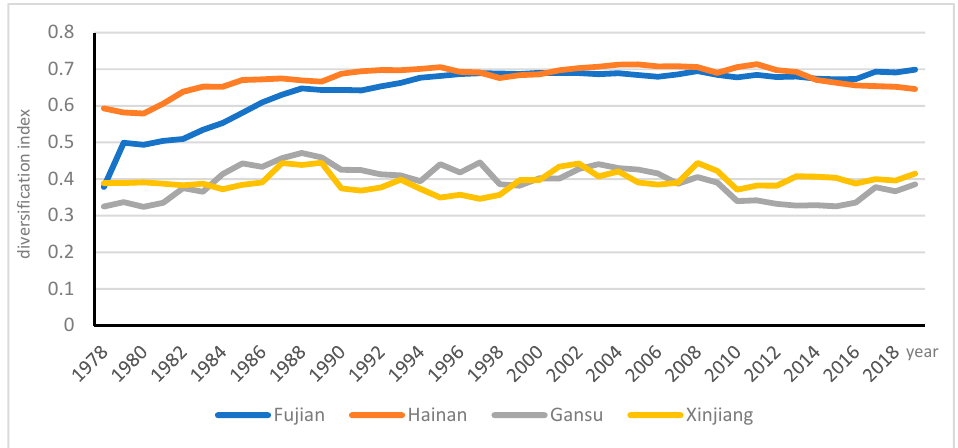
Figure 4. Trends of selected four provinces of highest and lowest diversification indices.